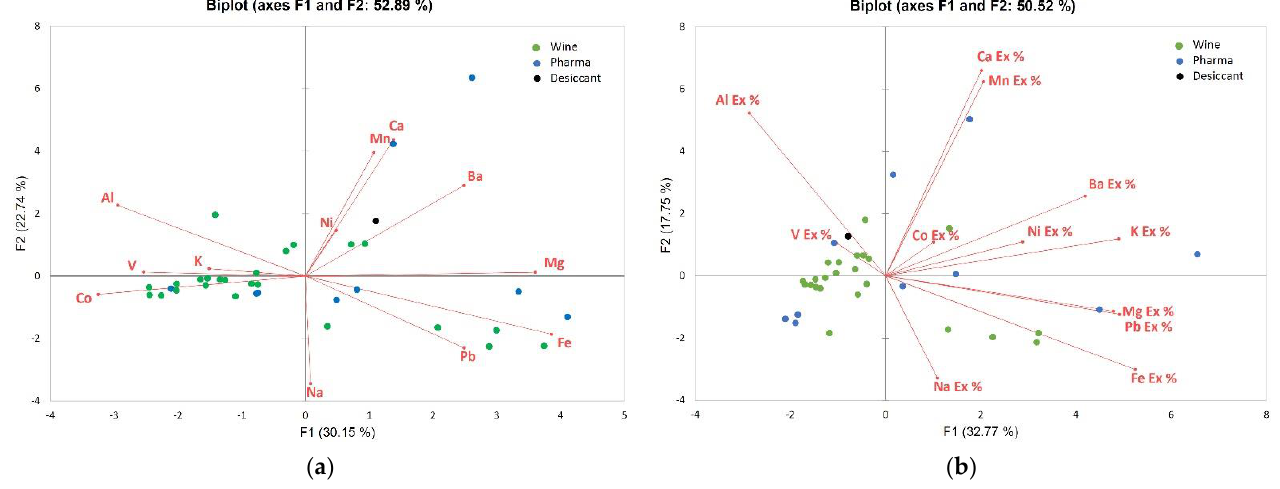
Figure 3. Principal component analyses of bentonite extracts, expressed as elements extracted ( a ) and percent extracted based on the analysis of the dry bentonites ( b ). Samples are grouped by intended use as wine-fining agent, pharma/beauty product, or desiccant.